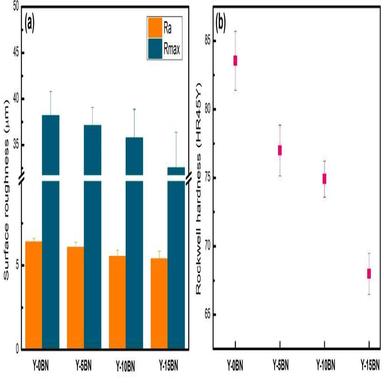
Surface roughness (a) and Rockwell hardness (b) of the Yb2Si2O7-based coatings with different hBN contents.